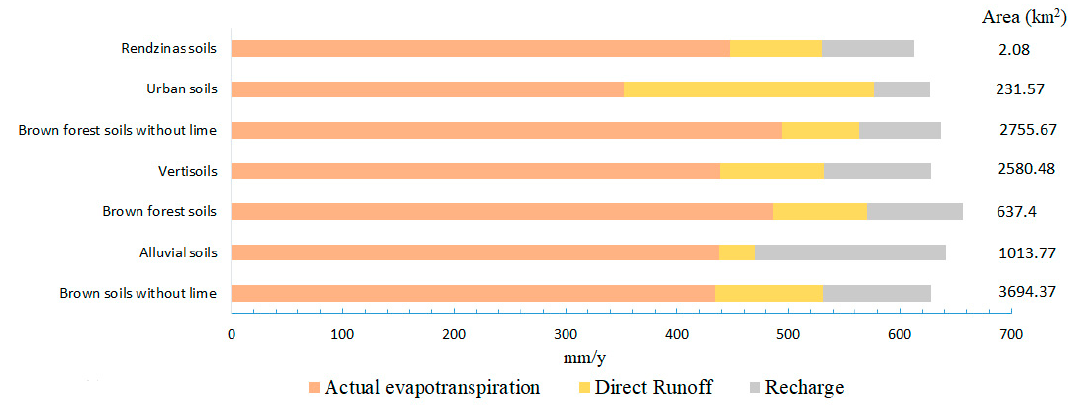
Figure 8. Average annual water budget quantities as in terms of CORINE_2012 land-use classifications.